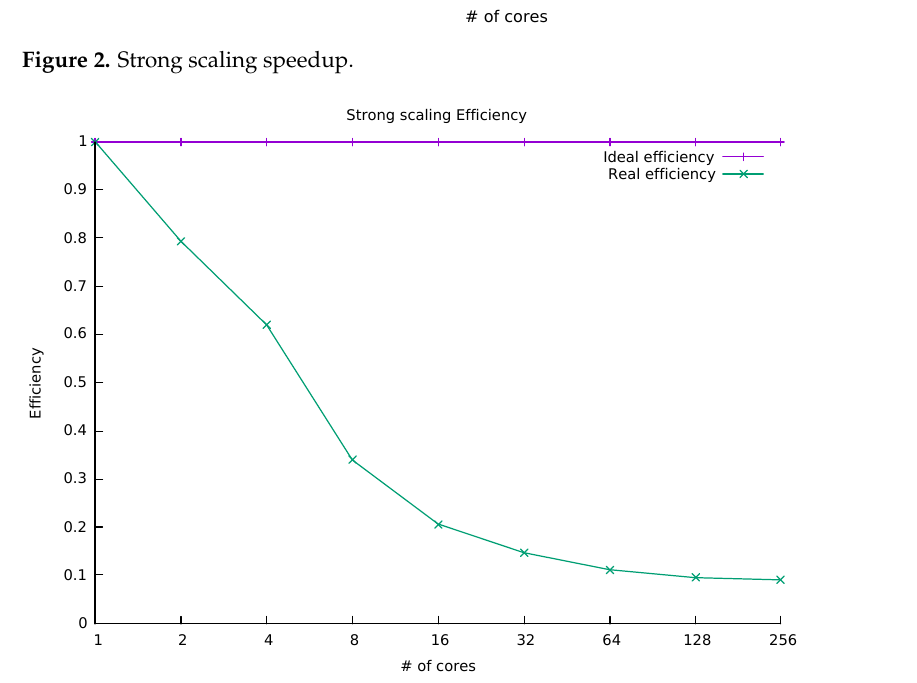
Figure 3. Strong scaling